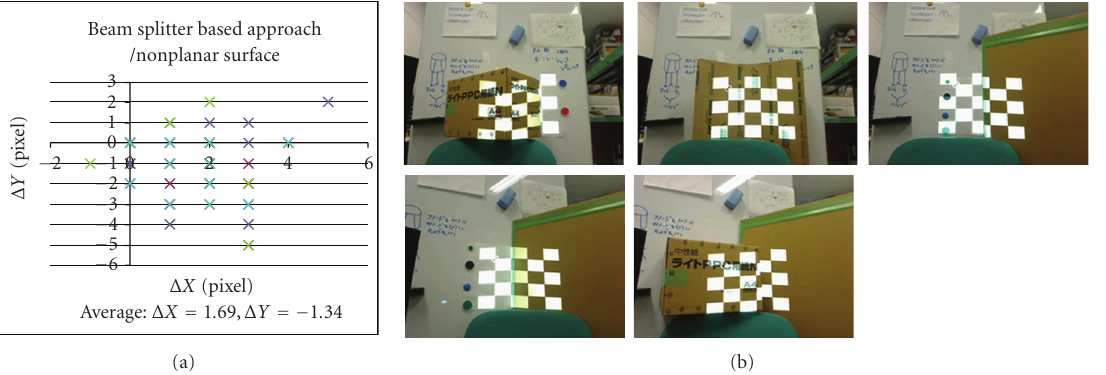
Figure 11: Geometric error (camera coordinates) of the beam-splitter-based approach on nonplanar